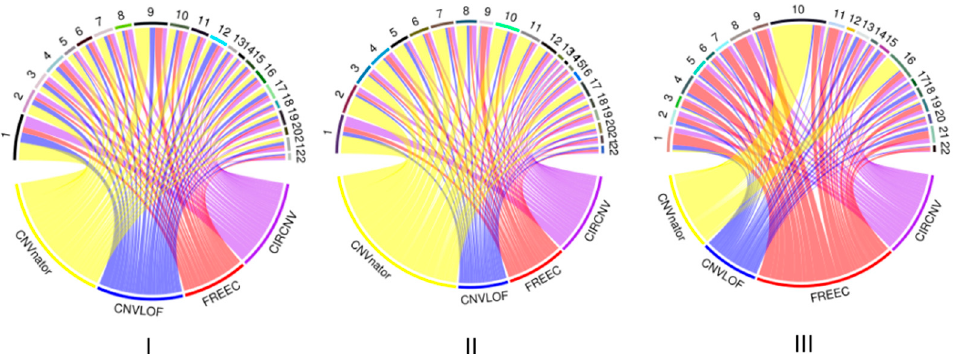
Figure 5. Performance comparisons between the first-round (using original RD profile) and the second-round (using corrected RD profile) CNV detected by the CIRCNV method with respect to sensitivity and precision. The simulation tumor purity ranges from 0.2 to 0.8, and the sequencing coverage depth is 6×.